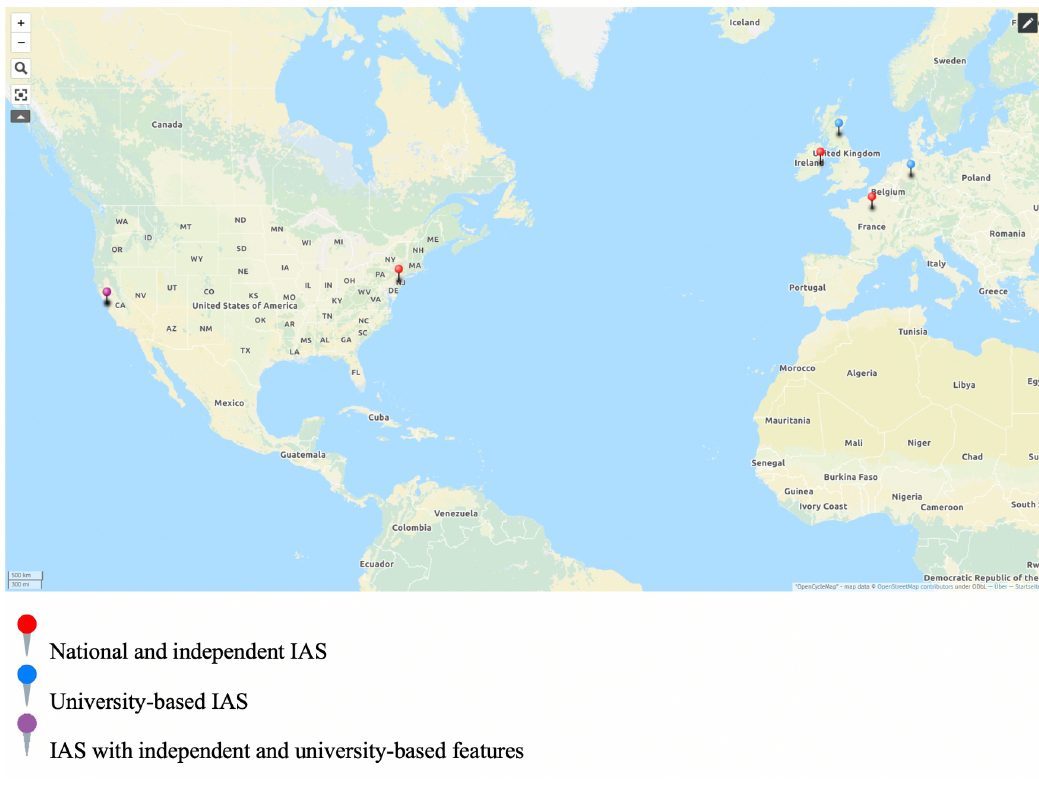
Fig. 1: The Pioneers